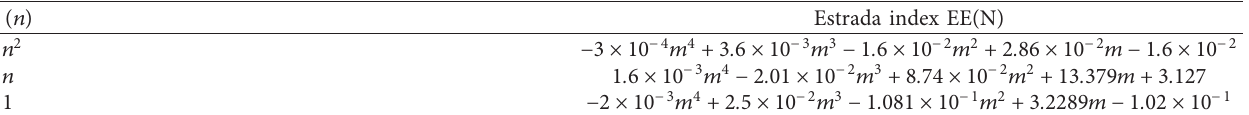
Table 3: All aforementioned equations are derived from the coefficient of the curves given in Table